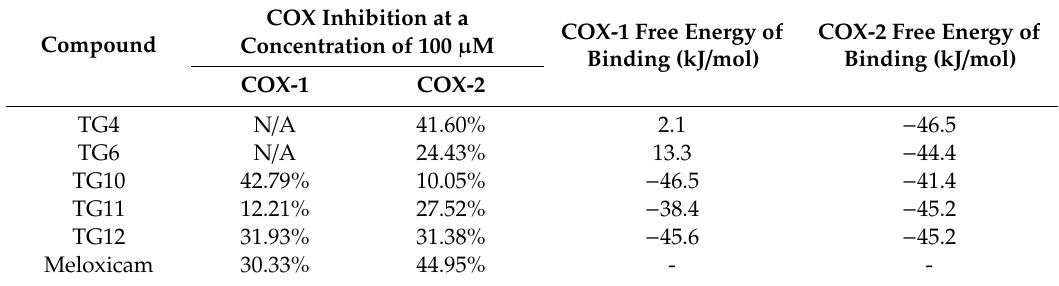
Table 2. Binding energies to COX-1 and COX-2 of the most active anti-COX compounds ( TG4 , TG6 , and TG10-TG12) .